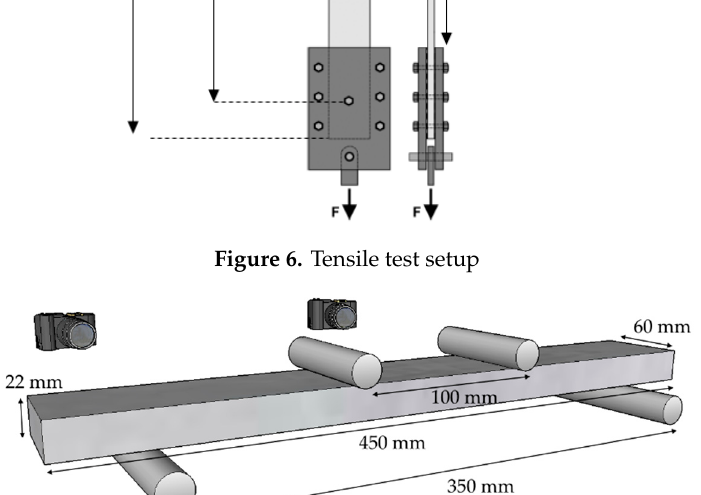
Figure 7. Four point bending test setup.